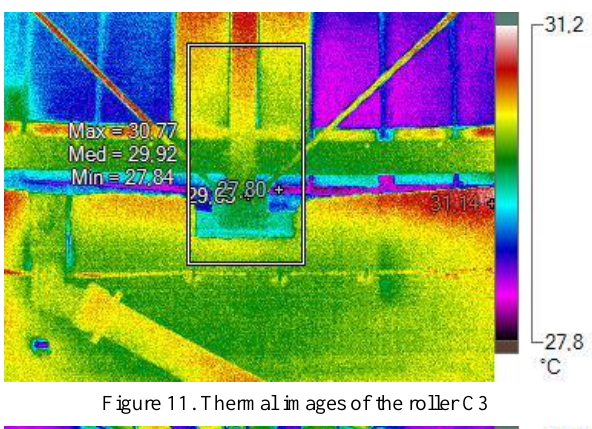
Figure 11. Thermal images of the roller C3